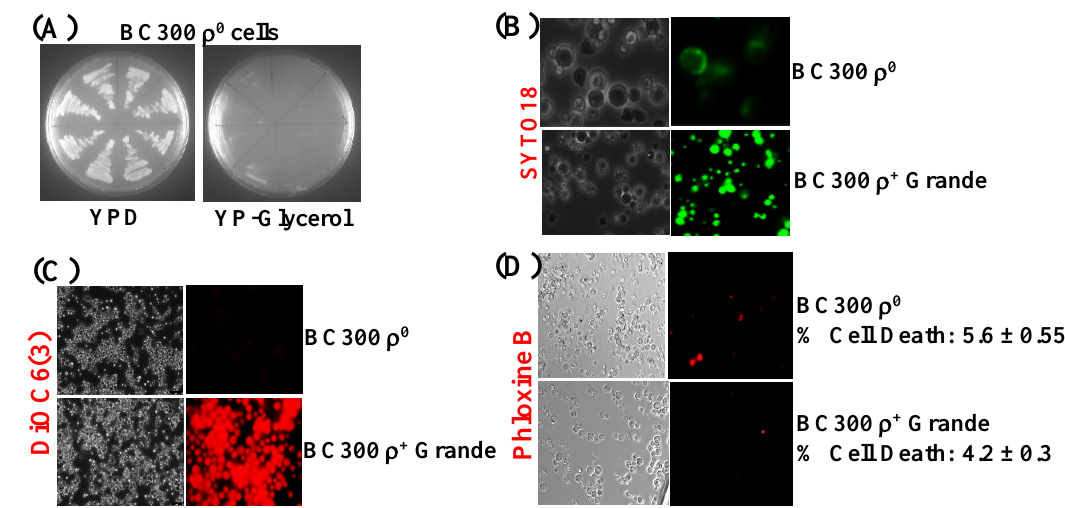
Figure 4. ( A ) Representative pictures of growth of ρ 0 BC300 yeast cells, formed after ethidium bromide treatment, on complete medium solid agar plates that contained either glucose (YPD) or Glycerol (YP-glycerol). ( B ) Microscopic images (×600) of ρ 0 petite and ρ + grande BC300 cells stained with the fluorescent dye SYTO18, which selectively stains yeast mtDNA. ( C ) Staining of ρ 0 petite and ρ + BC300 cells with the dye DiR/DiOC6(3) that detects MMP in live cells (×400). ( D ) Microscopic images (×400) of ρ 0 petite and ρ + BC300 cells stained with Phloxine B. Post Hoc Newman-Keuls test after a significant one-way ANOVA test, indicated a significant difference p < 0.001 between ρ 0 petite and ρ + BC300 strains in experiments ( B , C ), whereas, statistically, there was no difference between ρ 0 petite and ρ + cells in ( D ).